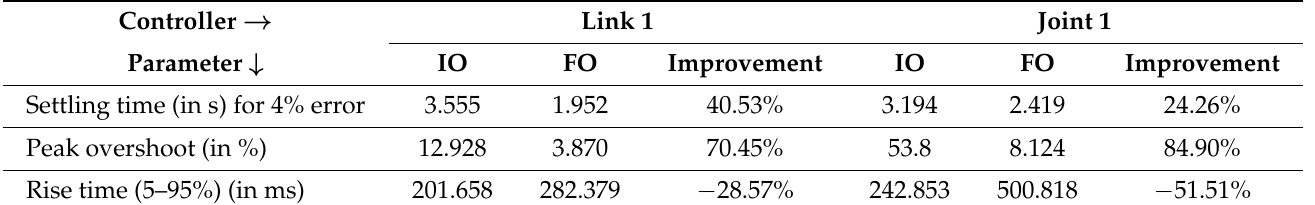
Table 3. Performance parameters of Link 1 and Joint 1.